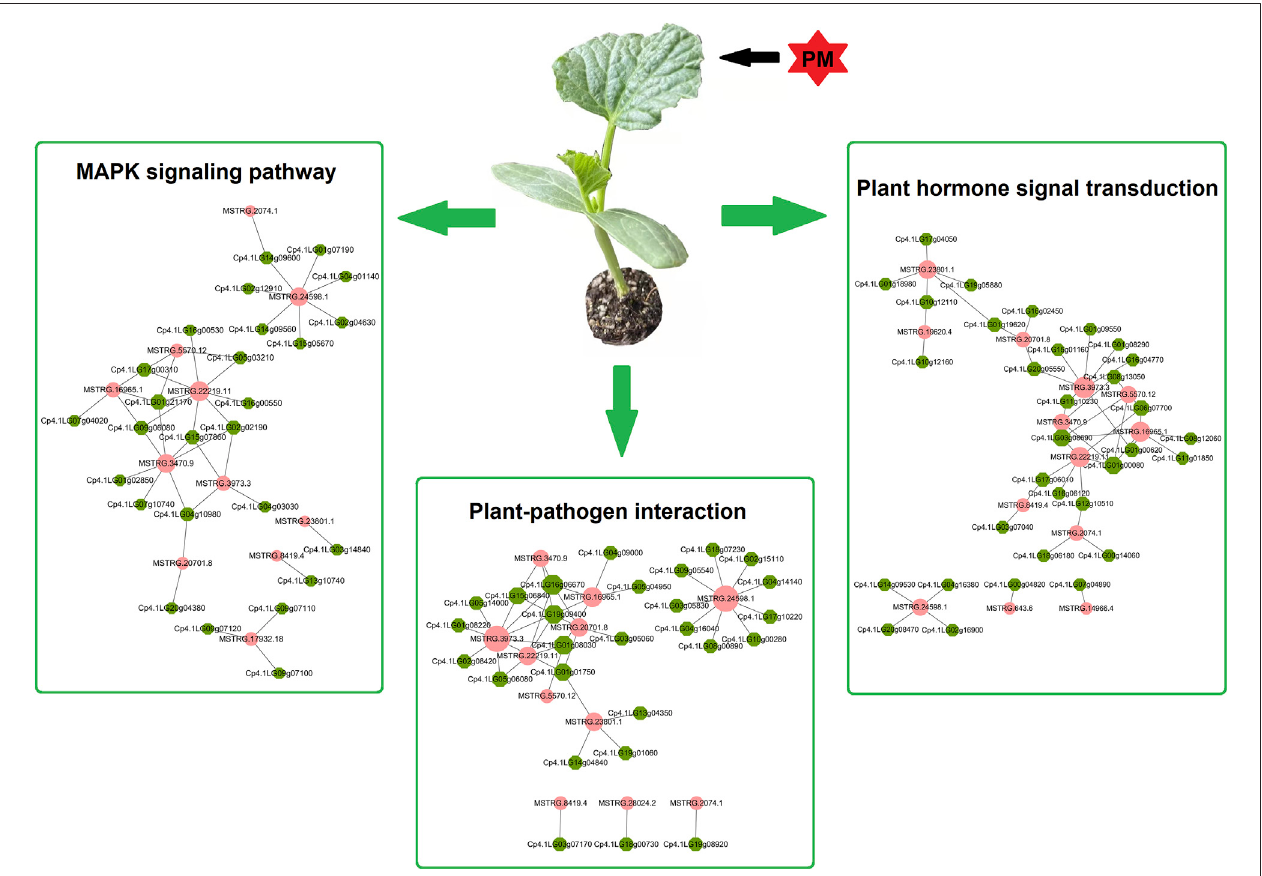
FIGURE 7 | Potential regulation network of lncRNAs and target genes involved in PM response. Potential target genes of PM-responsive lncRNAs are involved in the plant – pathogen interaction, MAPK signalling, and plant hormone signal transduction pathways. The pink circles represent lncRNAs, while the green hexagons represent potential target